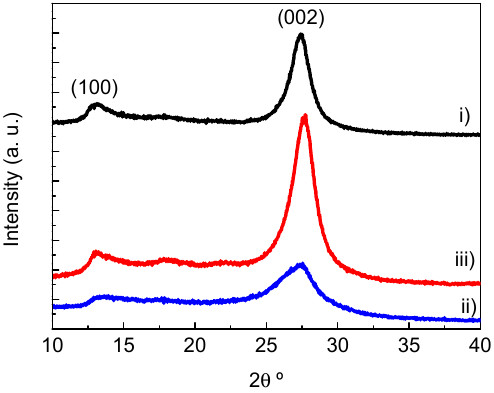
Figure 2. XRD pattern of (i) GCN, (ii) GCN-T-N, and (iii) GCN-T catalysts. The optical and electronic properties of GCN-based catalysts were evaluated through DR UV–vis and PL spectroscopies (Figure 3).